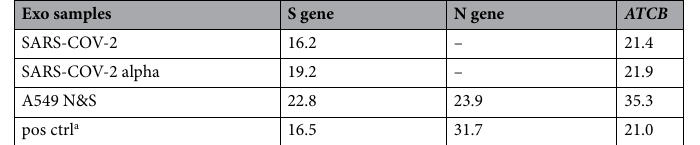
Table 2. Viral RNA in exosomes from culture supernatants of cell lines. a Positive control (pos ctrl) RNA provided by the manufacture; –, not detected by qPCR; ATCB , human β-actin gene.